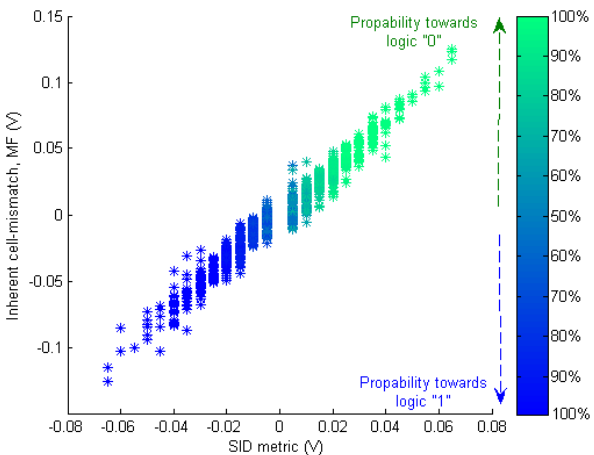
Figure 11. The relationship between the probability of the cell to starting up to a preferred state and the proposed metrics.